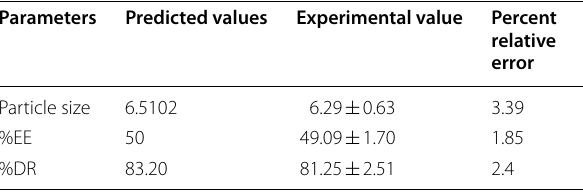
Table 5 Comparison between predicted and experimental values of